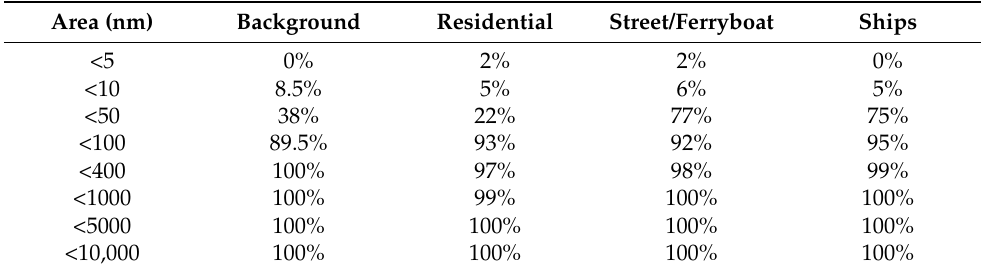
Table 1. Overview of the 8 size classes and their percentage share in the various emission sectors. Given shares are cumulative over the size distribution. Area (nm) Background Residential Street/Ferryboat